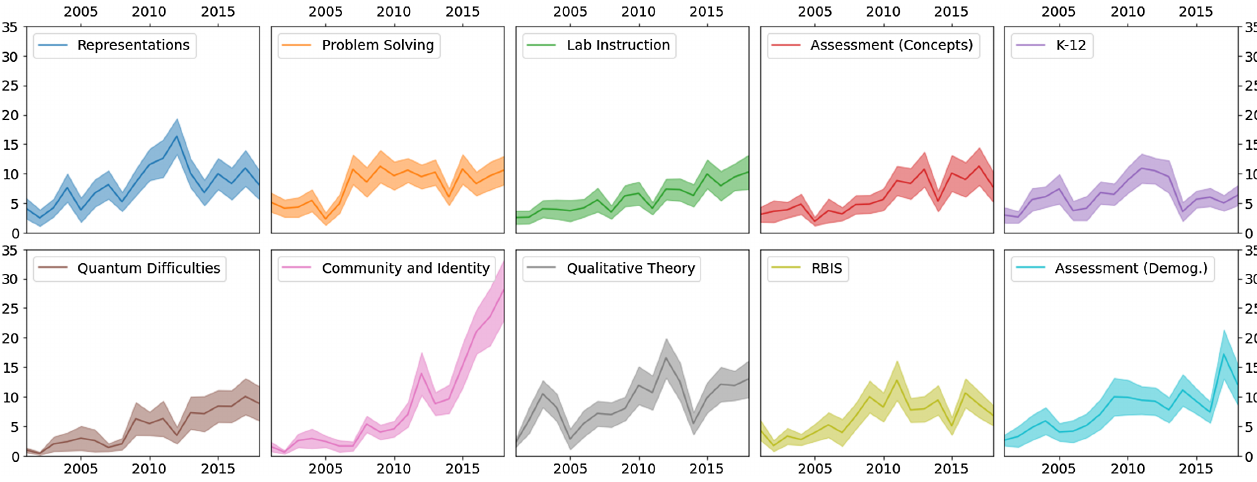
FIG. 7. Cumulative topic prevalence over time, with shaded areas based on a jackknife estimation of variance. A wider shaded area corresponds to a greater variance in the distribution of prevalence values, while a narrower shaded area indicates a more uniform distribution. The Y axis corresponds to the effective number of papers each year on that